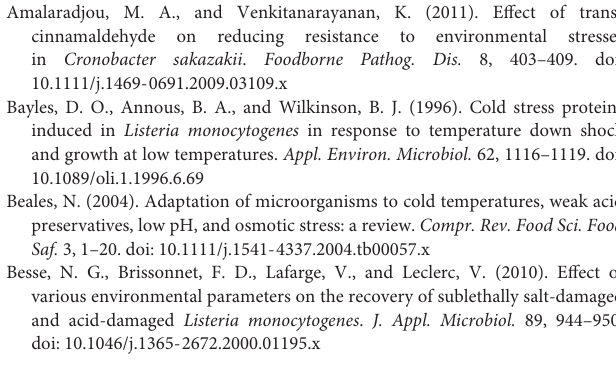
FIGURE S1 | Temperature profile of L. monocytogenes suspension during 405-nm LED illumination within acrylonitrile butadiene styrene housing at 4 ◦ C at a distance of 4.5 cm from the light